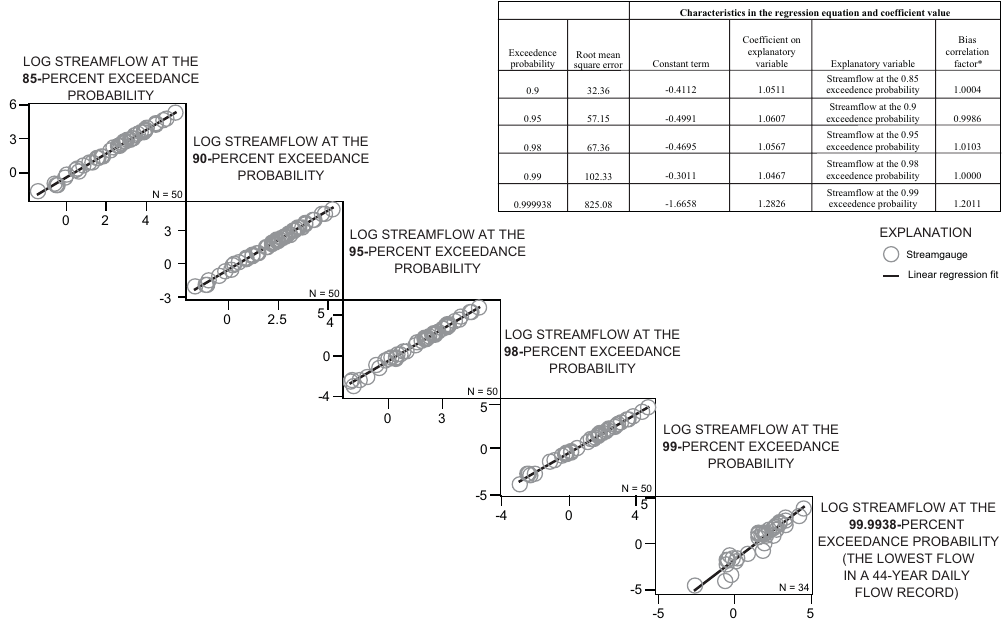
Fig. 5. Relations between streamflows at the 0.9, 0.95, 0.98, 0.99 and 0.999938 exceedance probabilities and the corresponding goodness of fit values resulting from a least-squares linear regression to estimate streamflows recursively from other streamflow quantiles. ( ∗ , Bias correction factor computed from Duan